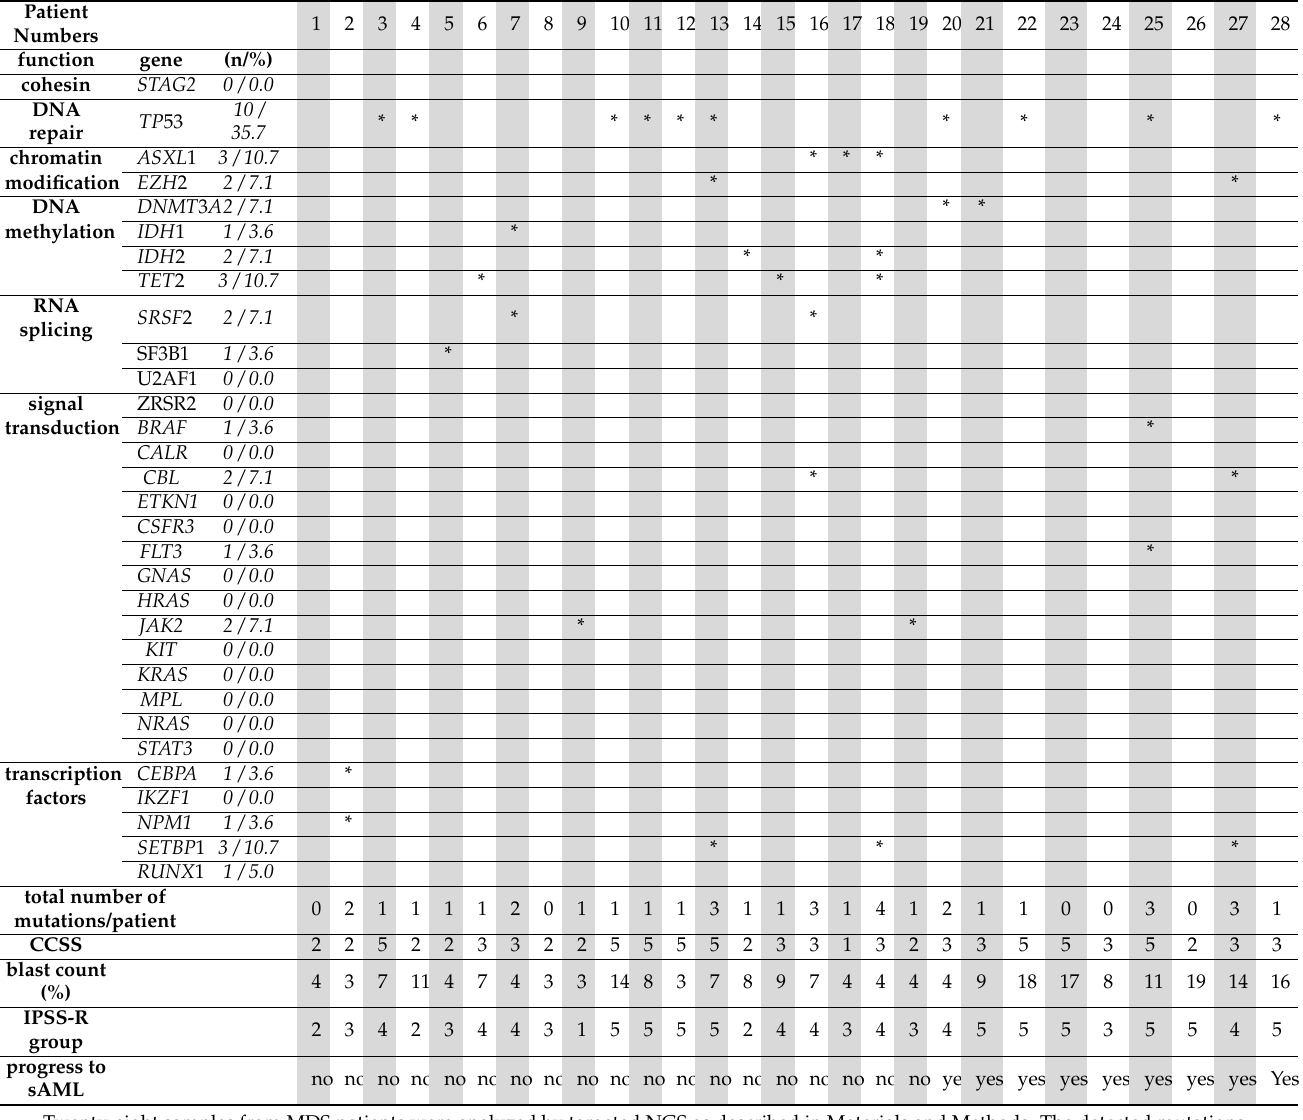
Table 2. Landscape of mutations and their prognostic relevance in MDS and progression to